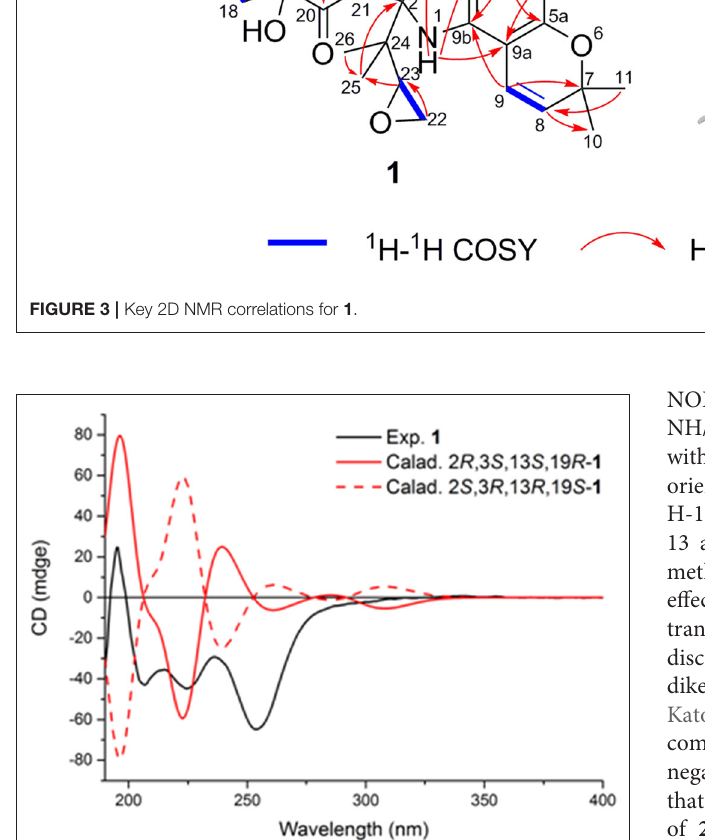
( Table 1 ) displayed the typical pattern of a prenylated